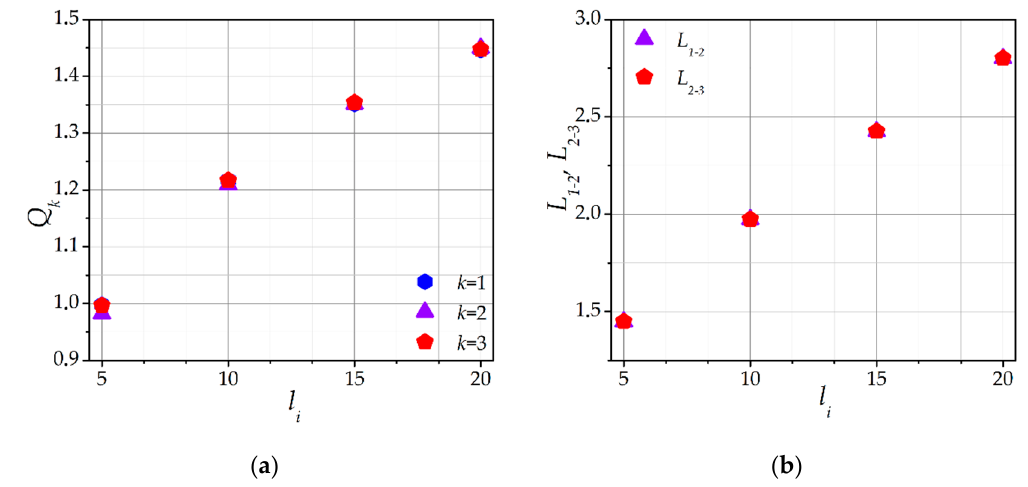
Figure 5. Dependence of the ( a ) self-consistent dust particle charges Q k , and ( b ) equilibrium interparticle distances L 1-2 and L 2-3 between the dust particles in a chain on the ion mean free path l i . F ext = − 0.2, E =0.